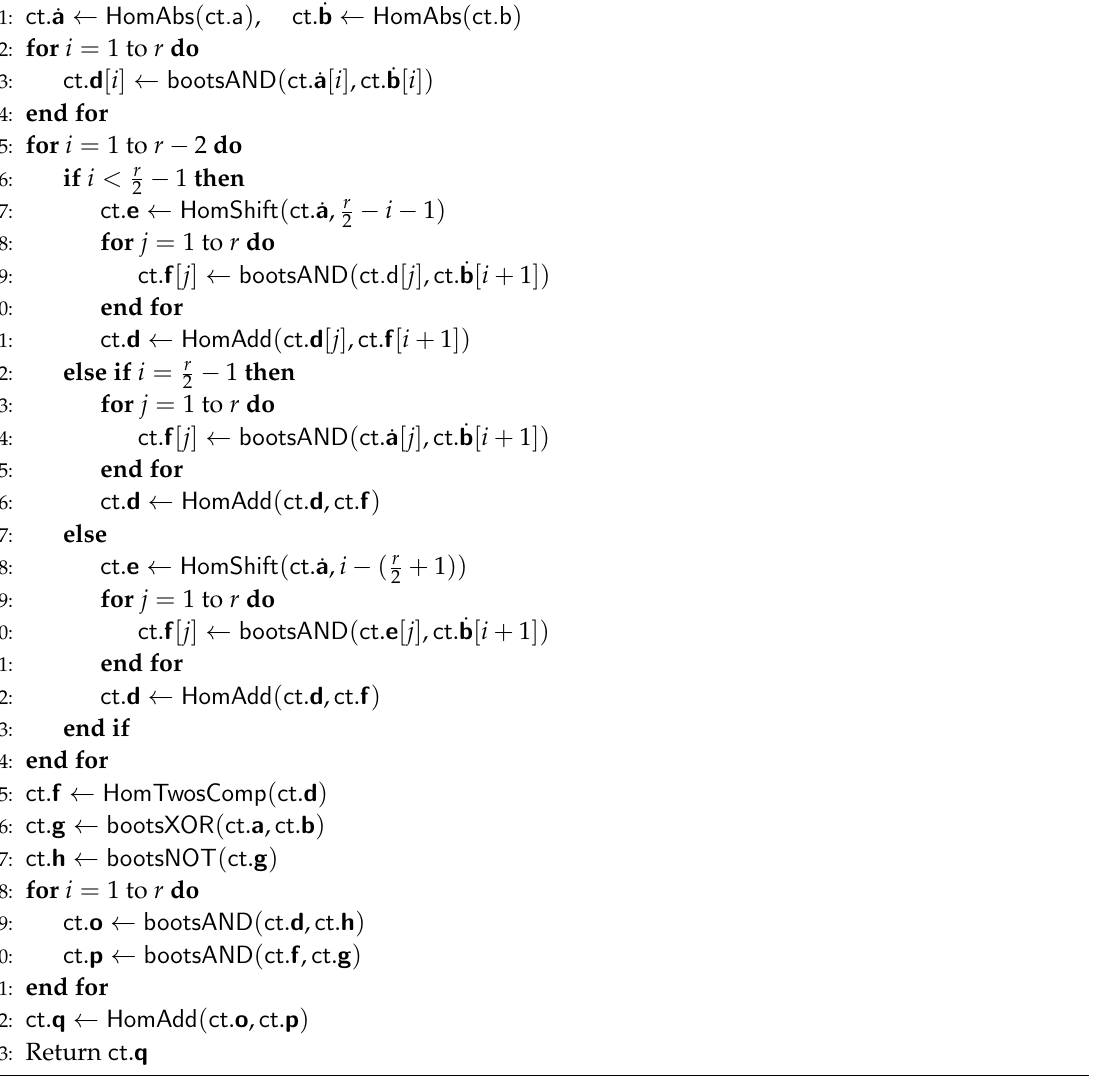
Algorithm 3 HomMulti ( ct. a , ct. b , r ): Homomorphic multiplication for matrix operation